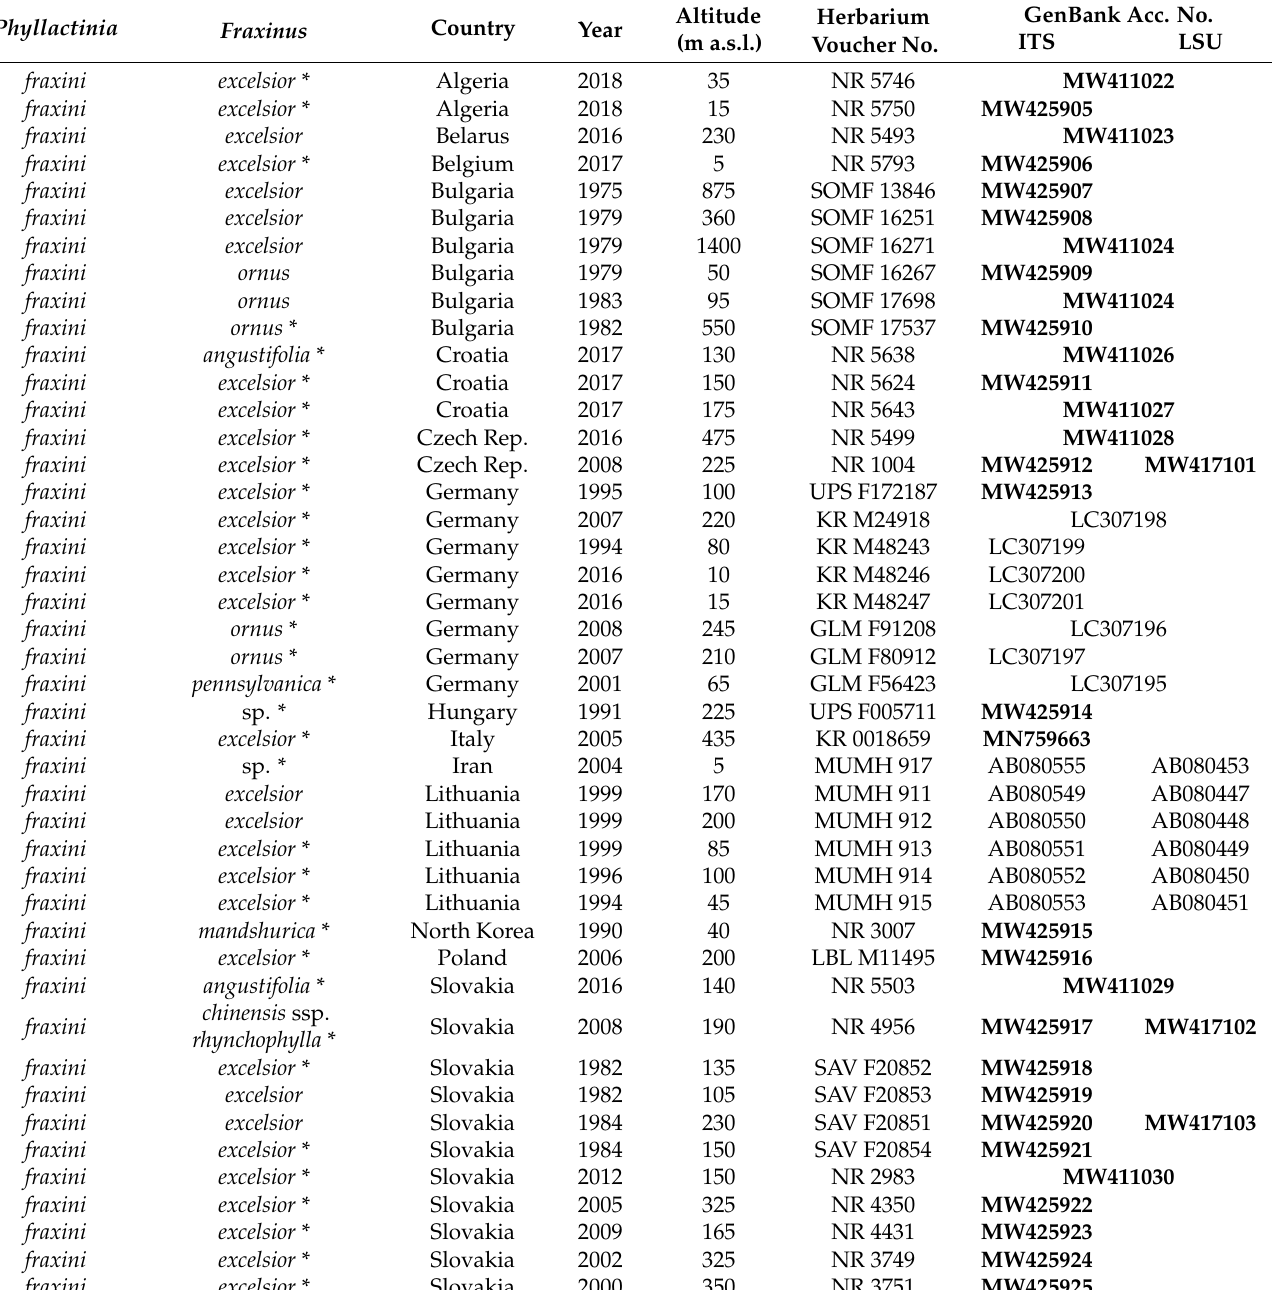
Table 2. List of Phyllactinia specimens on Fraxinus spp. used in this study. The accession numbers of the sequences obtained in this study are in